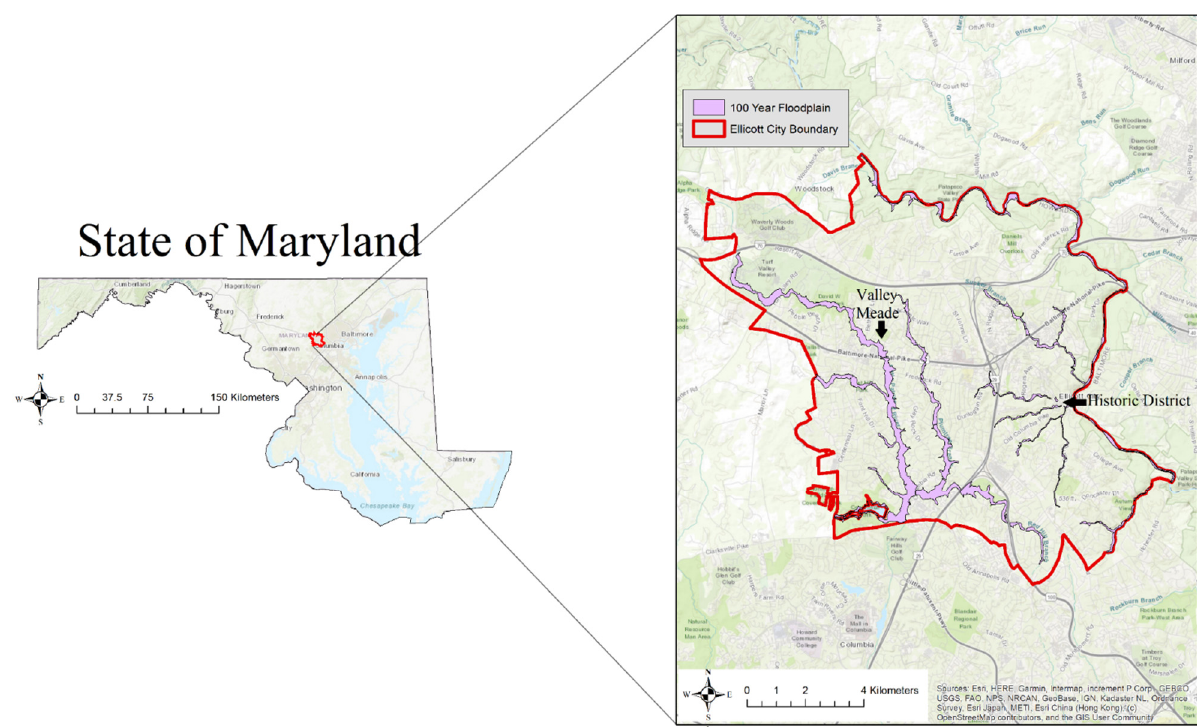
Figure 1. Our study site Ellicott City, MD and the 100-year floodplain (area with at least a 1% chance of flooding in a given year). Most participants either live/d or work/ed in the Historic District or Valley Meade during the flash flood(s). Maryland state boundary acquired from the US Census Bureau. Map was modified from Ellicott City Floodplains and Flood Zones [27].